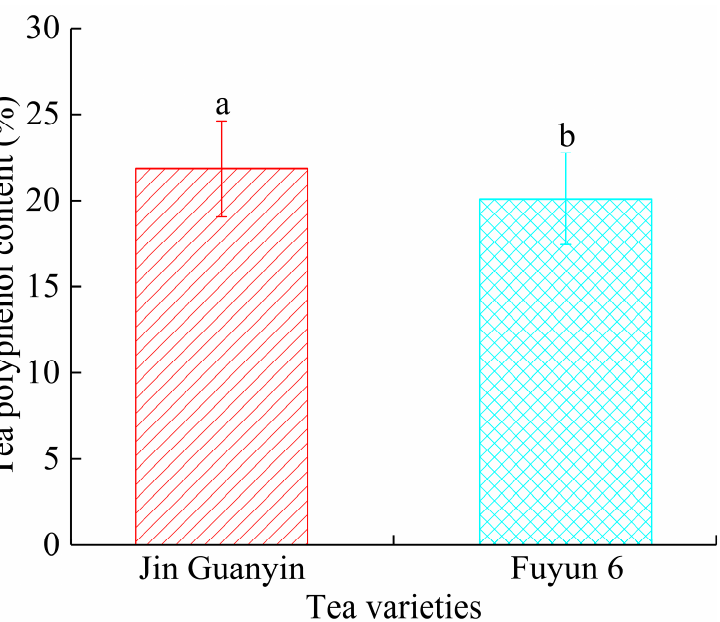
Figure 3. Histogram of tea polyphenol content in fresh tea leaves of two varieties. Note: Data are presented as mean ± standard deviation. The different letters (a and b) in the figures show significant differences in the tea polyphenol content of different varieties using Duncan test at p < 0.05 confidence level.